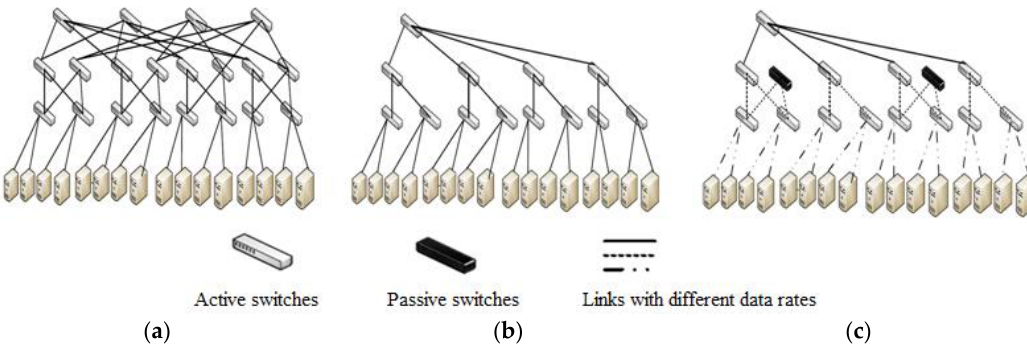
Figure 3. ( a ) Fat-tree ( b ) ElasticTree (MST) ( c ) Adaptive TrimTree: active + passive network + Rate Adaption.